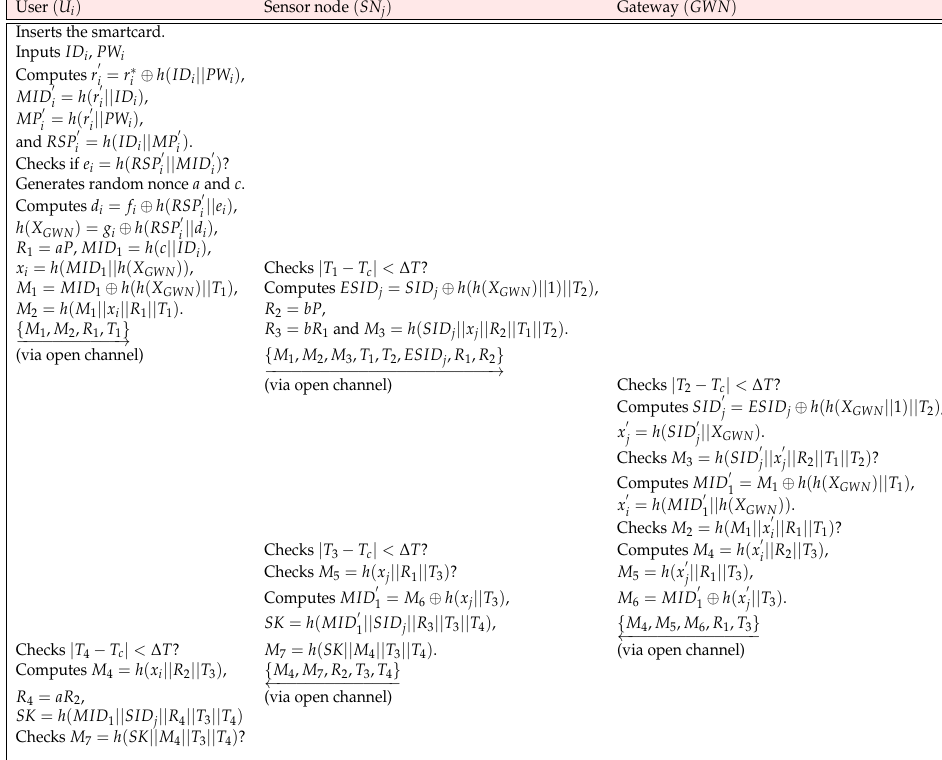
Figure 2. Login and authentication